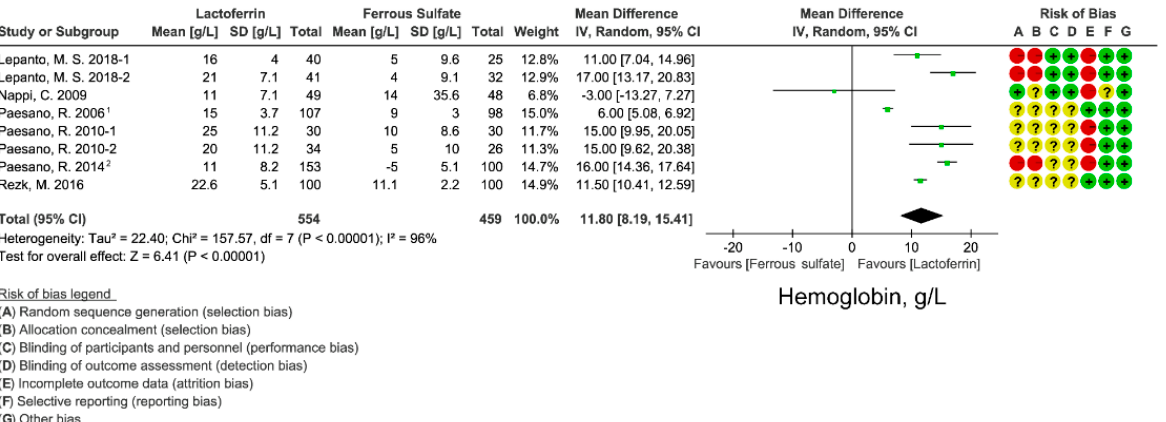
Figure 3. Effect of lactoferrin and ferrous sulfate on serum ferritin (SF) concentrations. 1. Mean and SD were estimated from histogram. Risk of bias legend: A = random sequence generation (selection bias); B = allocation concealment (selection bias); C = blinding of participants and personnel (perfor ‐ mance bias); D = blinding of outcome assessment (detection bias); E = incomplete outcome data (attrition bias); F = selective reporting (reporting bias); G = other bias. Data expressed as weighted mean difference (95% CI). IV, inverse variance.